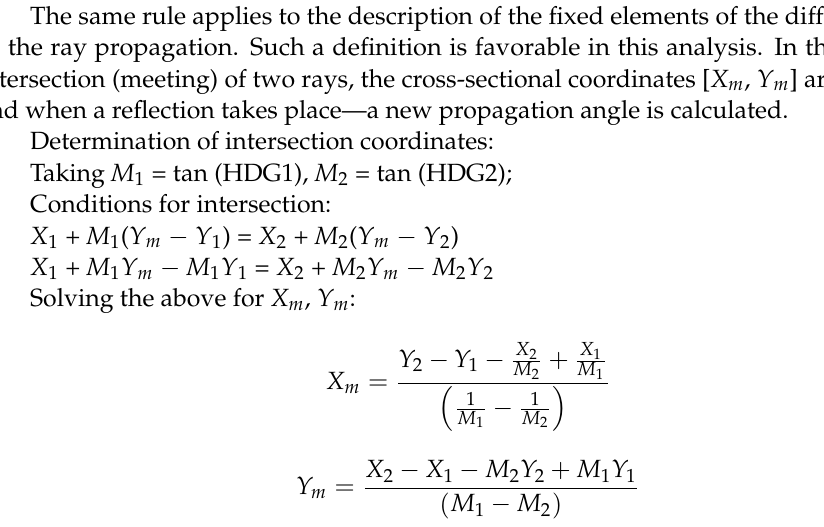
Figure 3. Geometry of ray tracing and determination of intersection coordinates using